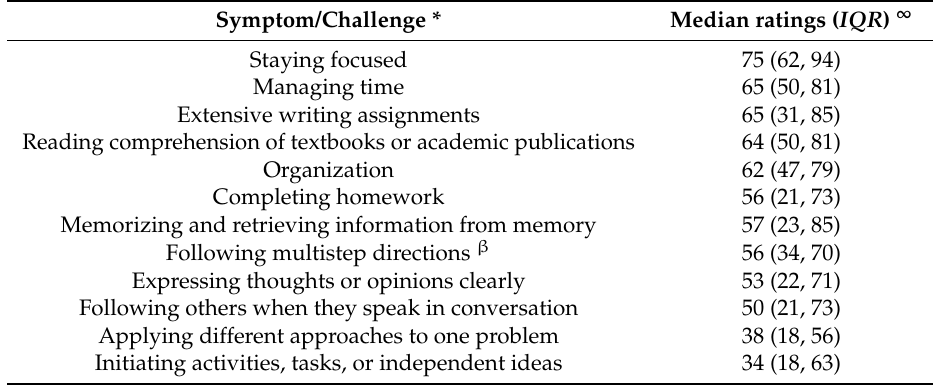
Table 2. Participant ratings of disability-related symptoms and